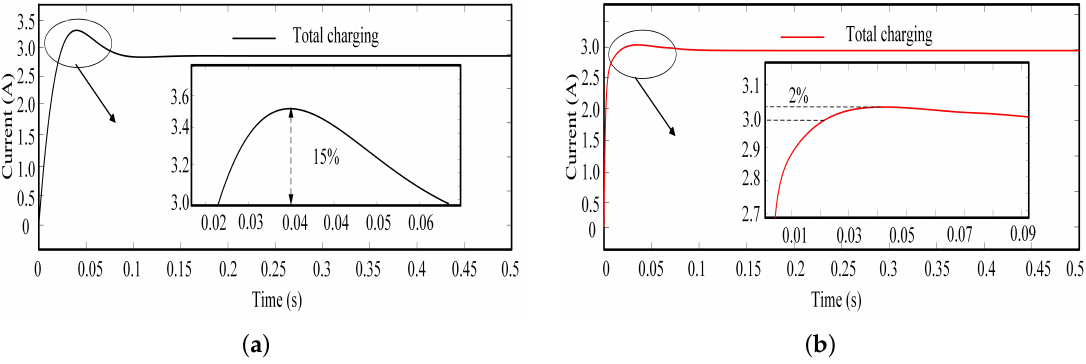
Figure 4. Simulation results of ( a ) the classical charging method and ( b ) the proposed charging method in total charging current.